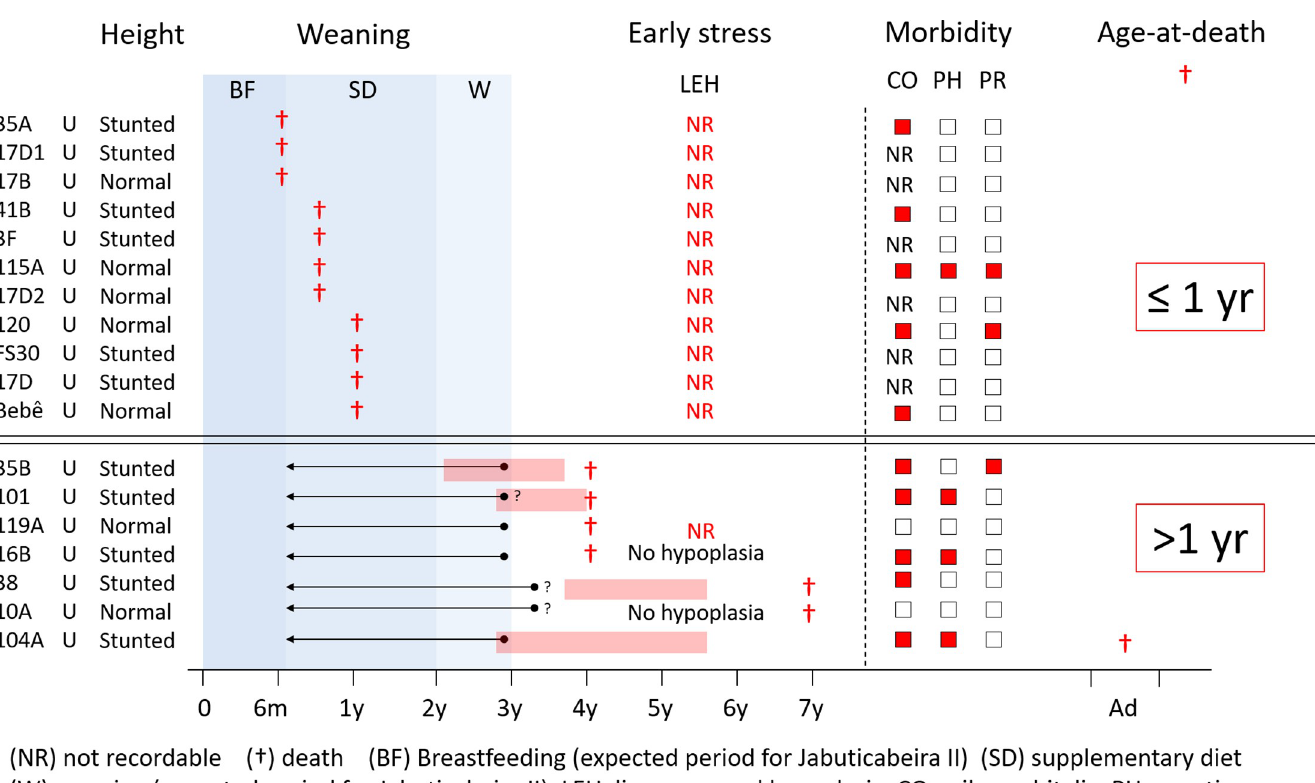
Fig 5. Physiological stress markers by individual in juveniles from Jabuticabeira